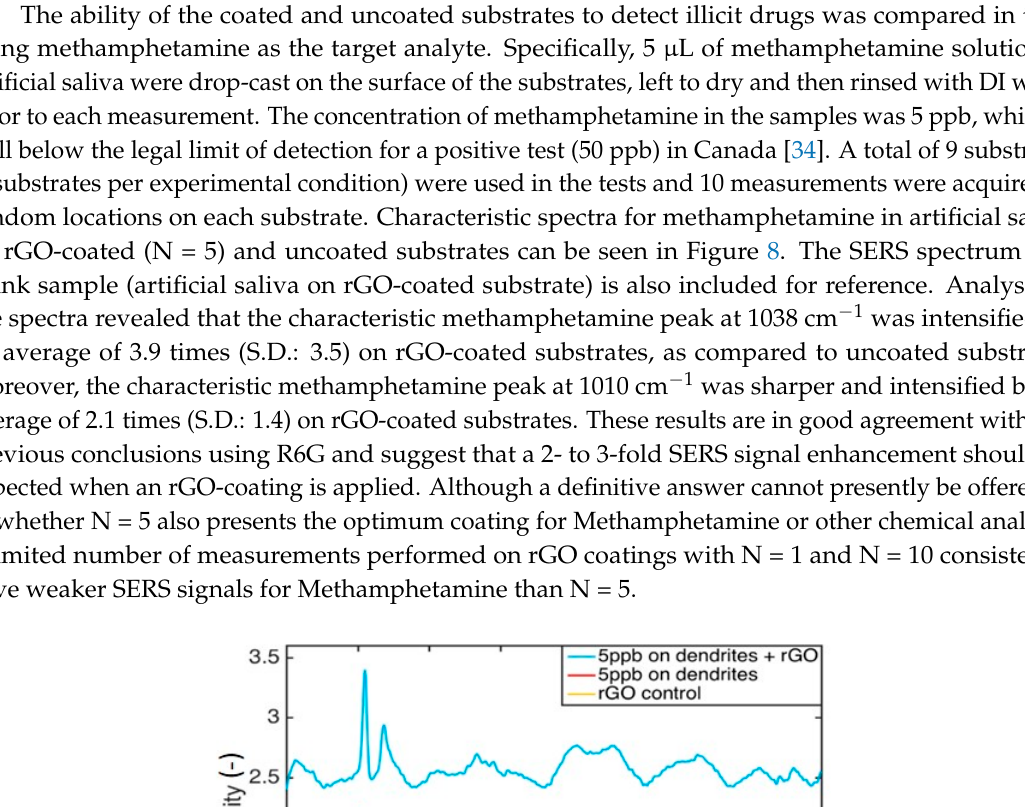
Table 1. Optimal number of spay nozzle passes for each graphene-based coating studied. Coating Solvent Optimal Passes, N 𝑹 𝑵𝒊 Standard Deviation (S.D.) GO Ethanol 25 2.3 0.64 rGO NMP 5 2.5 0.53 GNP NMP 1 1.6 0.45